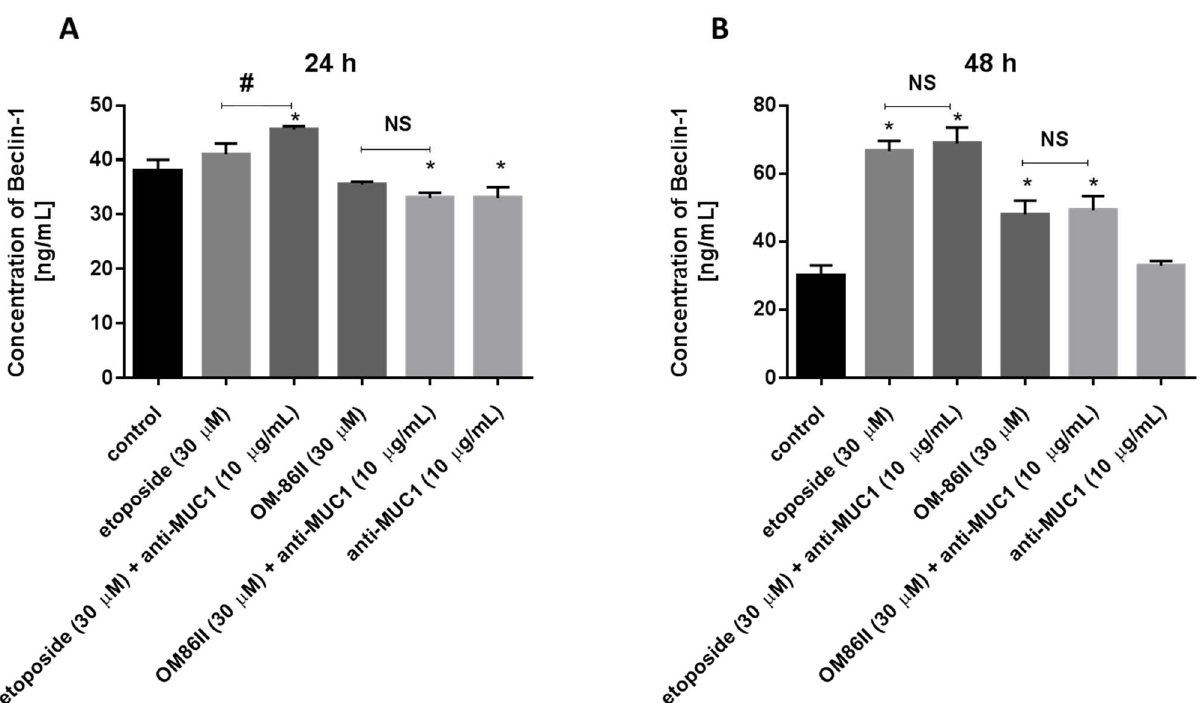
Figure 14. The concentration of Beclin-1 in human gastric cancer AGS cells after 24 h ( A ) and 48 h ( B ) of incubation with anti-MUC1 (10 µg/mL), OM-86II (30 µM), OM-86II + anti-MUC1 (30 µM + 10 µg/mL), etoposide (30 µM) and etoposide + anti-MUC1 (30 µM + 10 µg/mL). Data are presented in ng/mL. * p < 0.05 vs. control group; # p < 0.05. MUC1, mucin-1; OM-86II, octahydropyrazin[2,1-a:5,4-a′]diisoquinoline derivative; ns, not significant.